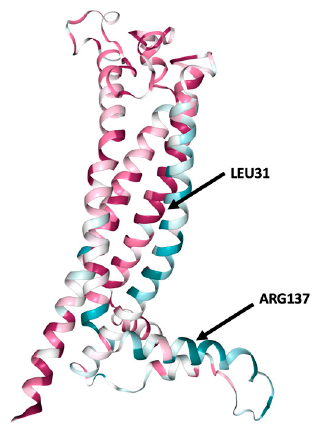
Figure 2. ConSurf analysis of conserved functional areas of the structural model of PLP1 gene-encoded protein. Amino acid at positions 31 (leucine) and 137 (arginine) are highlighted. Leucine in position 31 is a highly conserved region. Conservation score is presented in Figure S1.